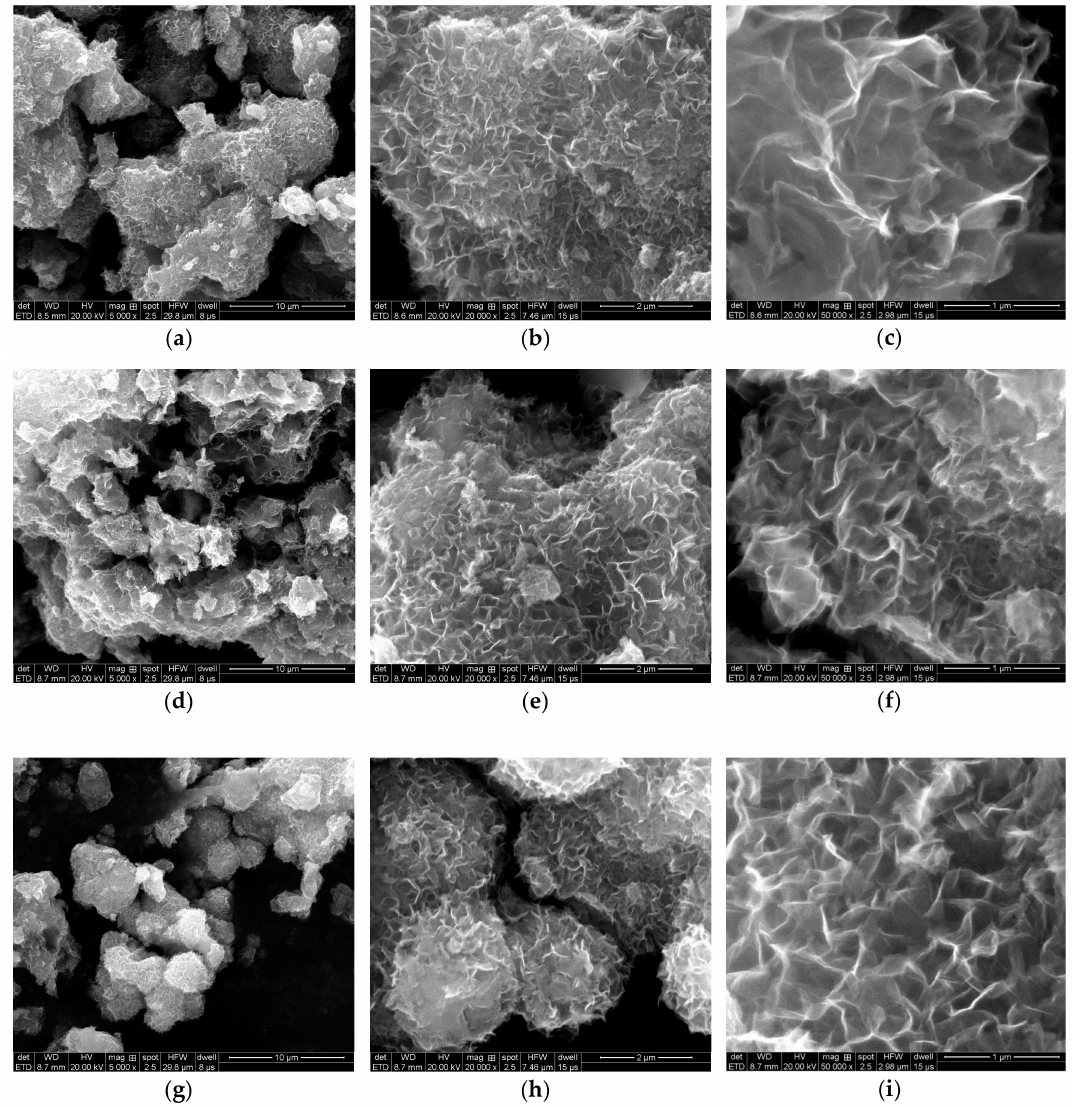
Figure 8. Scanning electron microscope (SEM) images of Fe–Mn co-oxide filter media during ( a , b , and c ) phase I; ( d , e , and f ) phase III; ( g , h , and i ) phase